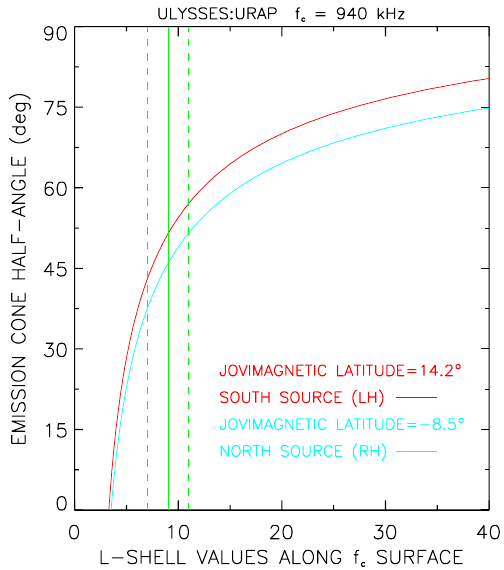
Fig. 9. Calculated values of emission cone half-angle β against L-shell for an assumed dipole magnetic field and an emission fre- quency of 940kHz. The jovimagnetic latitudes − 8 . 5 ◦ and 14 . 2 ◦ are the limiting values within which the HOM was observed. The solid green line represents L = 9. Dashed lines represent L = 7 and L = 11.